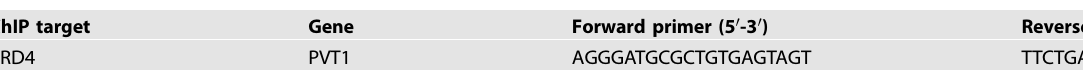
Table 3. The sequence of ChIP-qPCR